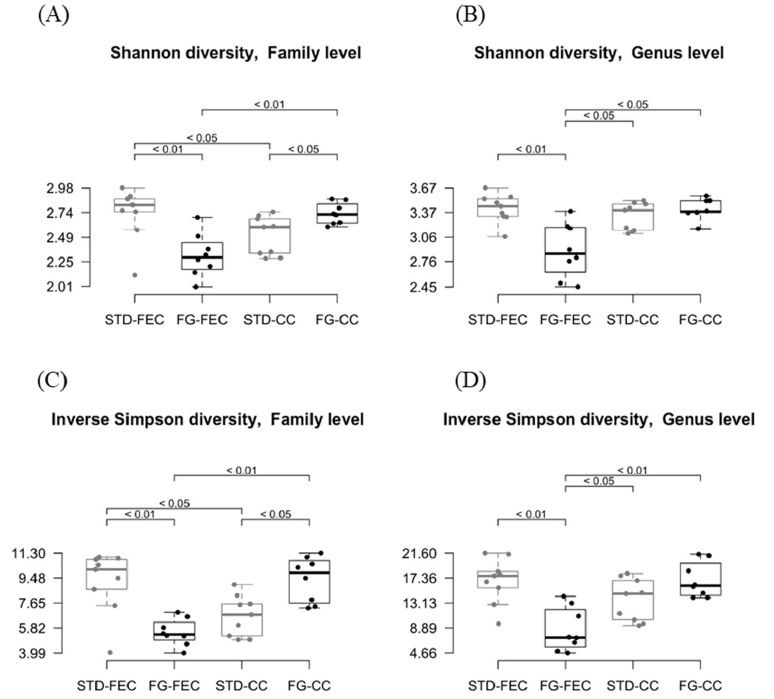
Figure 3. Estimates of Shannon ( A,B ) and inverse Simpson ( C,D ) α‐ diversities of fecal and cecal microbiota at family ( A,C ) and genus ( B,D ) levels in the STD (grey) and FG (black) groups of rats ( n = 8–9/group) at the end of the study (week 23). Statistical significance was assessed using the Wilcox test. In fecal samples, β‐ diversity was similar at the phylum, class, and order levels (Table 2). The weighted UniFrac distance was significantly ( p < 0.05) different at the family, ge ‐ nus, and species levels between controls and animals supplemented with D ‐ fagomine. In cecal content, the weighted UniFrac distance was significantly ( p < 0.05) different between the STD and FG groups at all the taxonomical levels. Table 2. β‐ diversity of the fecal and cecal microbiota in the STD and FG groups of rats ( n = 8– 9/group) at the end of the study (week 23). Weight UniFrac